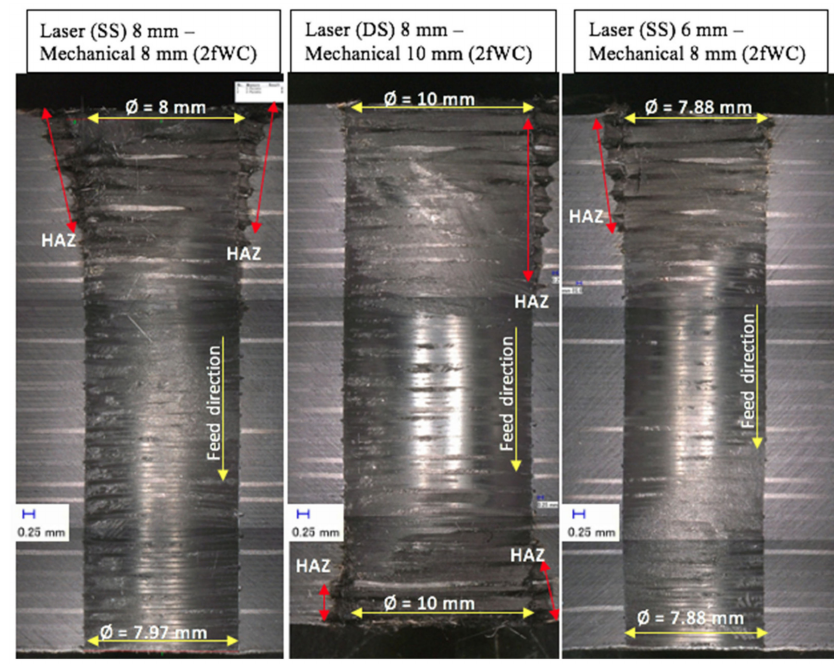
Figure 6. Typical cross-section views of sequential laser–mechanical drilling